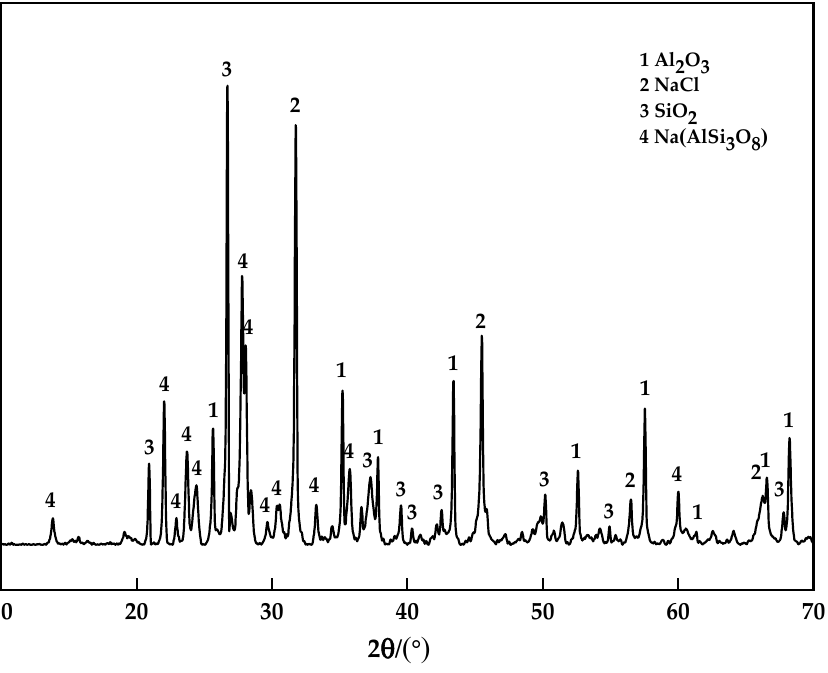
Figure 10. XRD pattern of the sample. It is believed that the main materials of sintered brick after sintering are quartz, alu- mina, albite and soluble salts. Compared with the XRD patterns of raw materials, it can be seen that the AlN and Al in the aluminum dross disappear and transform into correspond- ing oxides after sintering. More importantly, albite is formed during the sintering process. At high temperatures, albite can form eutectic with quartz and aluminosilicate, fill between the crystal grains of the brick, and draw the particles closer under the effect of surface tension, making the brick more compact. The main crystalline phases are alumina, quartz and albite. These crystalline phases constitute the main framework of the sintered brick. The formation of new crystalline phase albite plays a key role in promoting sintering. Figure 11a–c show the micro morphology of samples containing 30%, 50% and 70% aluminum dross, and Figure 11d shows the micro morphology of samples without alu- minum dross. Then, it can be clearly seen that a glass phase appears inside the sintered brick without aluminum dross, which causes the particles to begin to melt and bond. It can be seen from Figure 11d that the glass phase is evenly distributed on the surface of the sample and connected with each other, which improves the mechanical strength of the sintered brick. Figure 11a–c show that with the increase of aluminum dross content, the glass phase inside the sintered brick becomes less and the porosity increases. This leads to a significant decrease in the mechanical properties of sintered bricks. However, with the addition of aluminum dross, the shape of crystal particles in the brick becomes more regular. As shown in Figure 11c, crystal particles mostly exist in the form of rods, strips and flakes. These are intertwined with each other, which helps to improve the mechanical properties of bricks to a certain